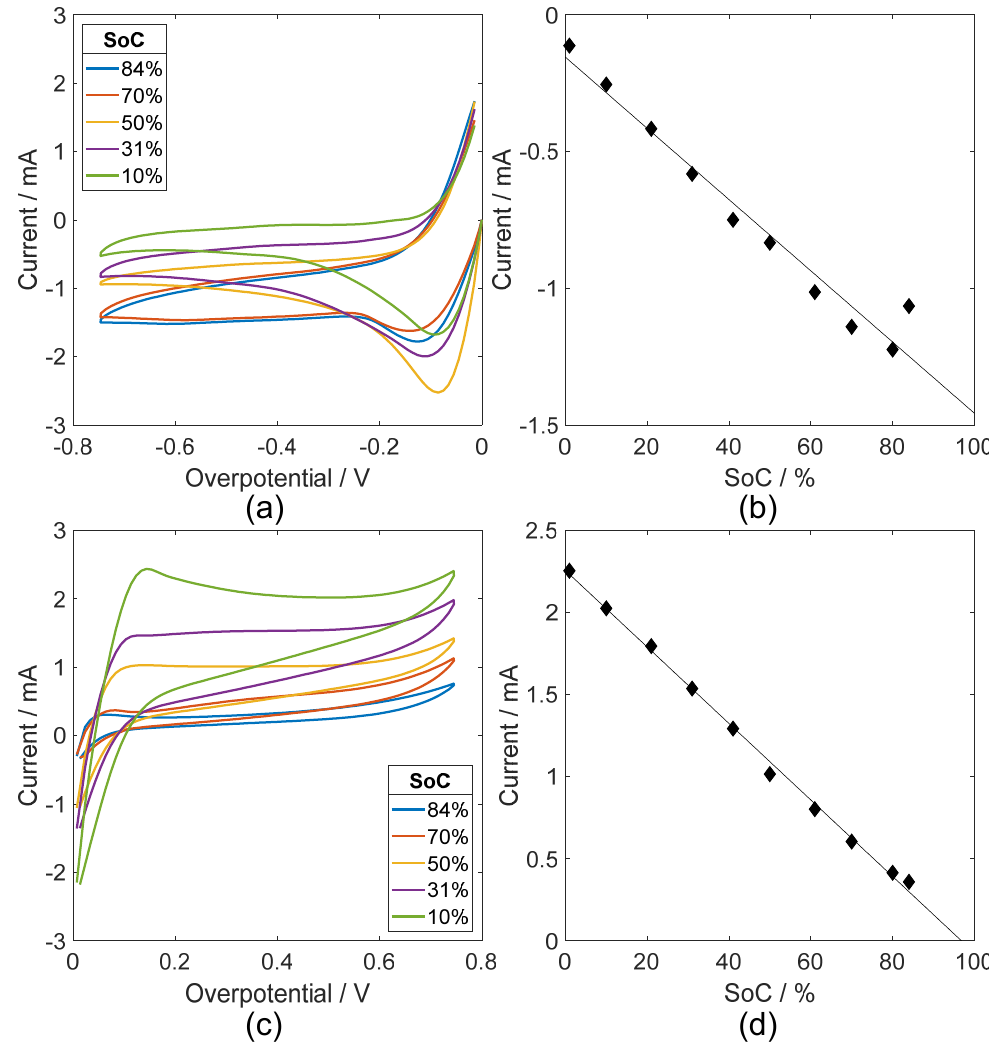
Figure 5. Results of CV measurements with sensor in positive electrolyte with different SoCs; reduction current curves; ( a ) current values versus SoC, ( b ) oxidation current curves, ( c ) current values versus SoC, ( d ) (scan rate 20 mV/s, platinum pseudo reference, active area 1 cm²).